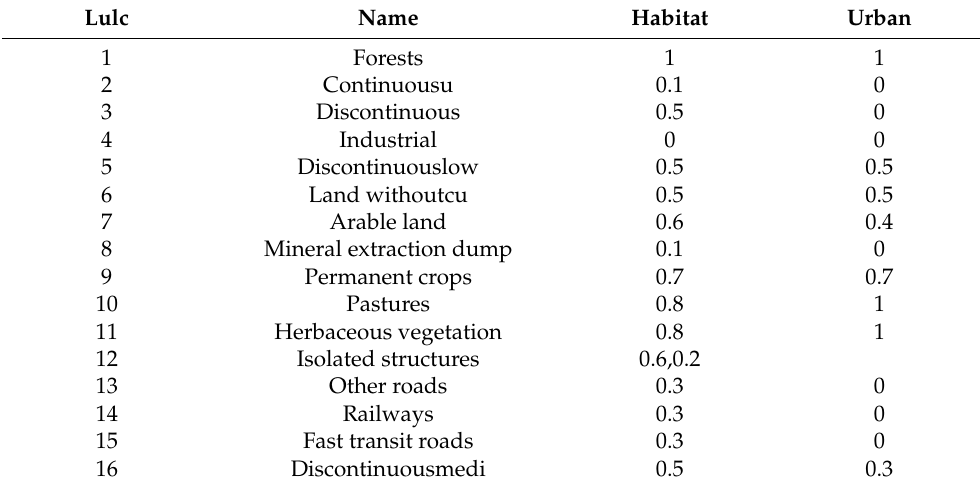
Table 1. Sensitivity Table of the Habitat Quality model. Lulc